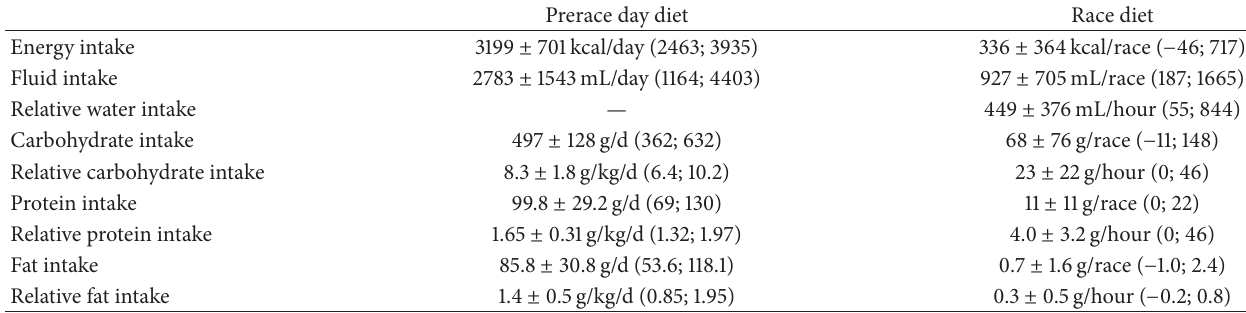
Table 2: Prerace day nutrition and dietary intake during mountain races in 𝑁 = 6 elite